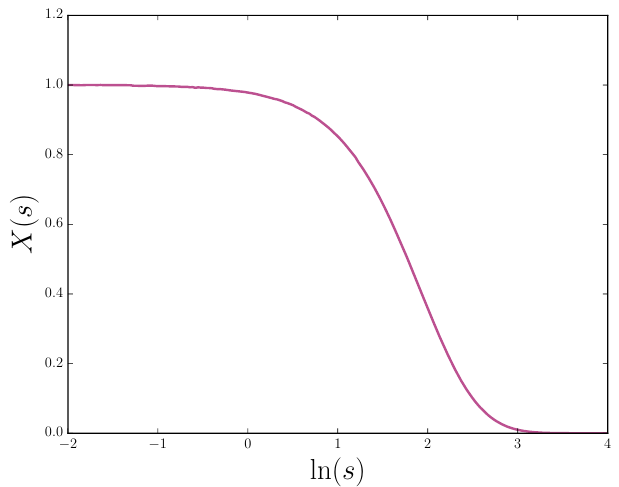
Figure 2 . The absorption cross-section (normalised to the point-particle cross-section) X ( s ) against s , the strength of the tidal terms. Independent of the wavelength of the particle, the cross-section is reduced by a factor which becomes smaller as s increases, reaches 1 = 2 at around s eventually becomes exponentially